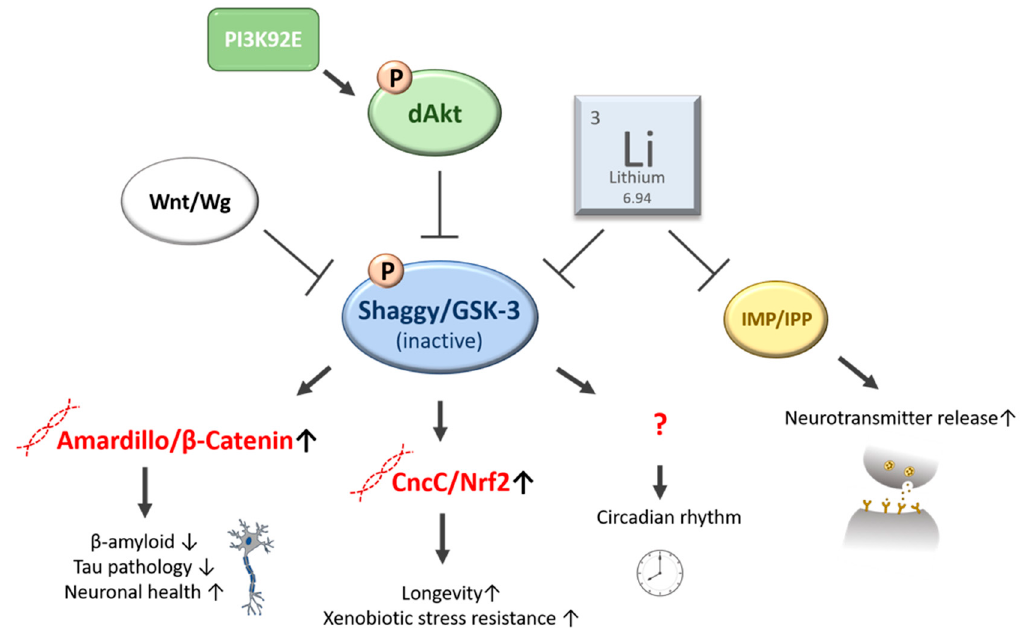
Figure 3. Overview of molecular targets of lithium in D. melanogaster . In the fly, lithium (atomic number: 3, relative atomic weight: 6.94) is thought to inhibit two major targets: (i) Shaggy/GSK-3, which is also a target of the insulin signaling and the Wnt pathway, and (ii) IMP/IPP. In disease models of D. melanogaster , inactivation/phosphorylation of Shaggy/GSK-3 increases intracellular levels of the transcriptional factor Amardillo/ β -Catenin, which is associated with decreasing levels of beta-amyloid and tau pathology as well as improvement of neuronal health. Li-induced inactivation of Shaggy can also increase levels of the transcription factor CncC/Nrf2, which is likely to be the cause of the observed longevity and xenobiotic stress resistance. Effects of Li on the circadian rhythm are not yet explained but are also associated with Shaggy- inhibition. Independently of Shaggy/GSK-3, Li increases neuronal signaling, as it promotes synaptic neurotransmitter vesicle release through inhibition of IMP/IPP. PI3K, phosphatidylinositol 3-kinase; dAkt, protein kinase B; Wnt/Wg, wingless; Shaggy/GSK-3, glycogen synthase kinase 3; IMP/IPP, Inositol monophosphatase/Inositol polyphosphate 1-phosphatase; CncC/Nrf, cap-n-collar C/Nuclear factor E2-related factor 2.